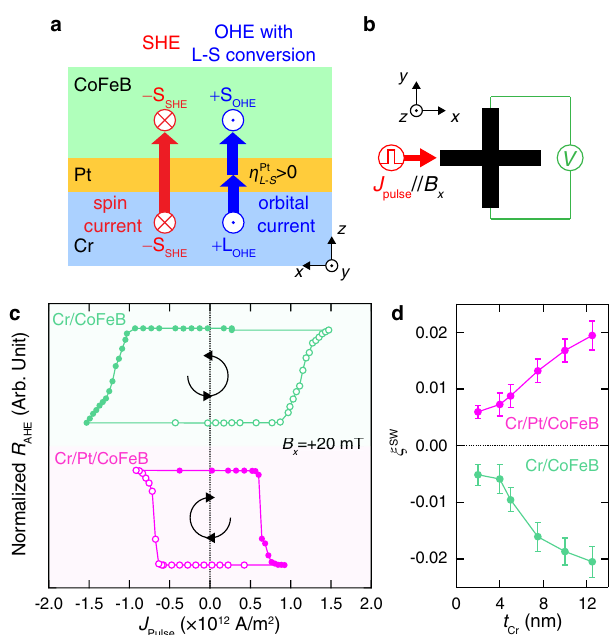
Fig. 3 Orbital-Hall-torque-driven magnetization switching by in Cr/Pt/ CoFeB heterostructures. a Schematic illustration of the orbital-to-spin conversion by η Pt L in the Cr/Pt/CoFeB heterostructure. The spin (orbital) (cid:2) S angular momentum is represented by S ( L ). The source of S and L is marked by the subscript of SHE (OHE) for spin Hall effect (orbital Hall effect). b The magnetization switching measurement geometry for a Hall-bar sample, in which an in-plane magnetic fi eld B x is applied along the pulsed current J pulse . c Magnetization switching curves of Cr (10.0nm)/CoFeB (0.9 nm) and Cr (10.0nm)/Pt (1.0 nm)/CoFeB (0.9 nm) samples under a B x of + 20 mT. The green and magenta symbols represent the samples without and with the Pt insertion layer, respectively. Open (closed) symbols indicate magnetization switching from down-to-up (up-to-down) directions. The switching polarity is indicated by an arrow in the center of curve. d t Cr -dependent switching ef fi ciency ( ξ SW ) of the Cr/CoFeB (green) and Cr/Pt/CoFeB (magenta) samples. Lines are guide to eyes. All measurements are conducted at 300 K. The error bars in d are due to the standard deviation of fi ttings of B C = B P /cos θ which is ( B P ) estimation. Here, where B P is the domain wall propagation fi eld, B C is the coercive fi eld, and θ is the polar angle of the magnetic fi eld (Supplementary Note 10).